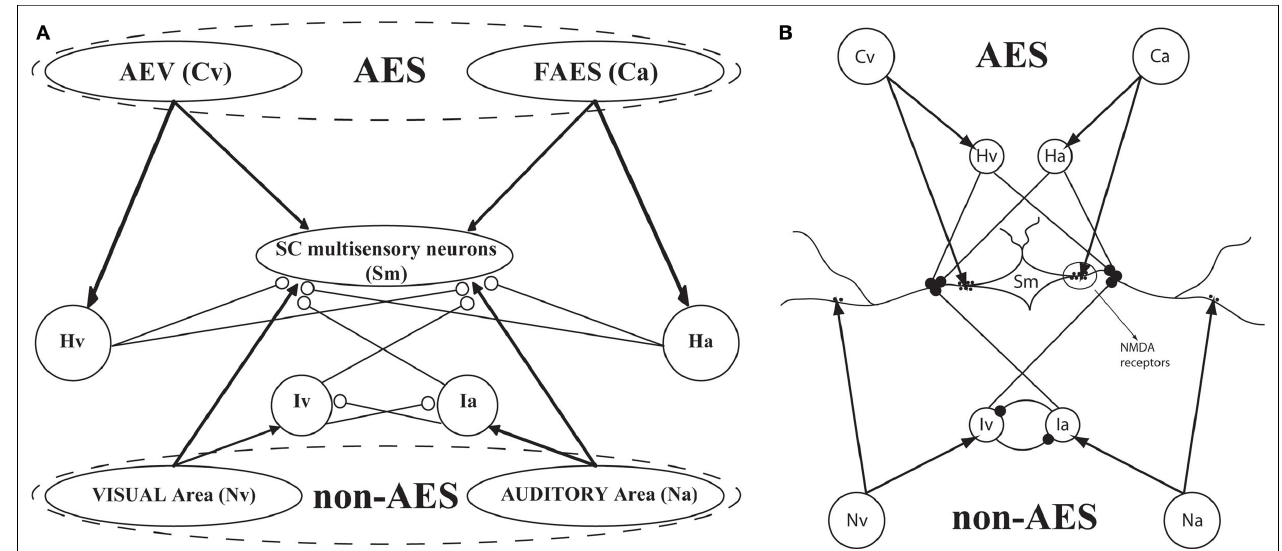
FIGURE 1 | The general structure of the network (A) and its physiological counterpart (B). The four projection areas (AES and non-AES) make excitatory connections (arrows) with the SC and with interneurons. The interneurons work in concert to provide two competitive mechanisms based on their inhibitory synapses (dots). Ha and Hv = interneurons receiving auditory (a) or visual (v) input from cortex; Ia, Iv = interneurons receiving auditory and visual inputs from non-AES